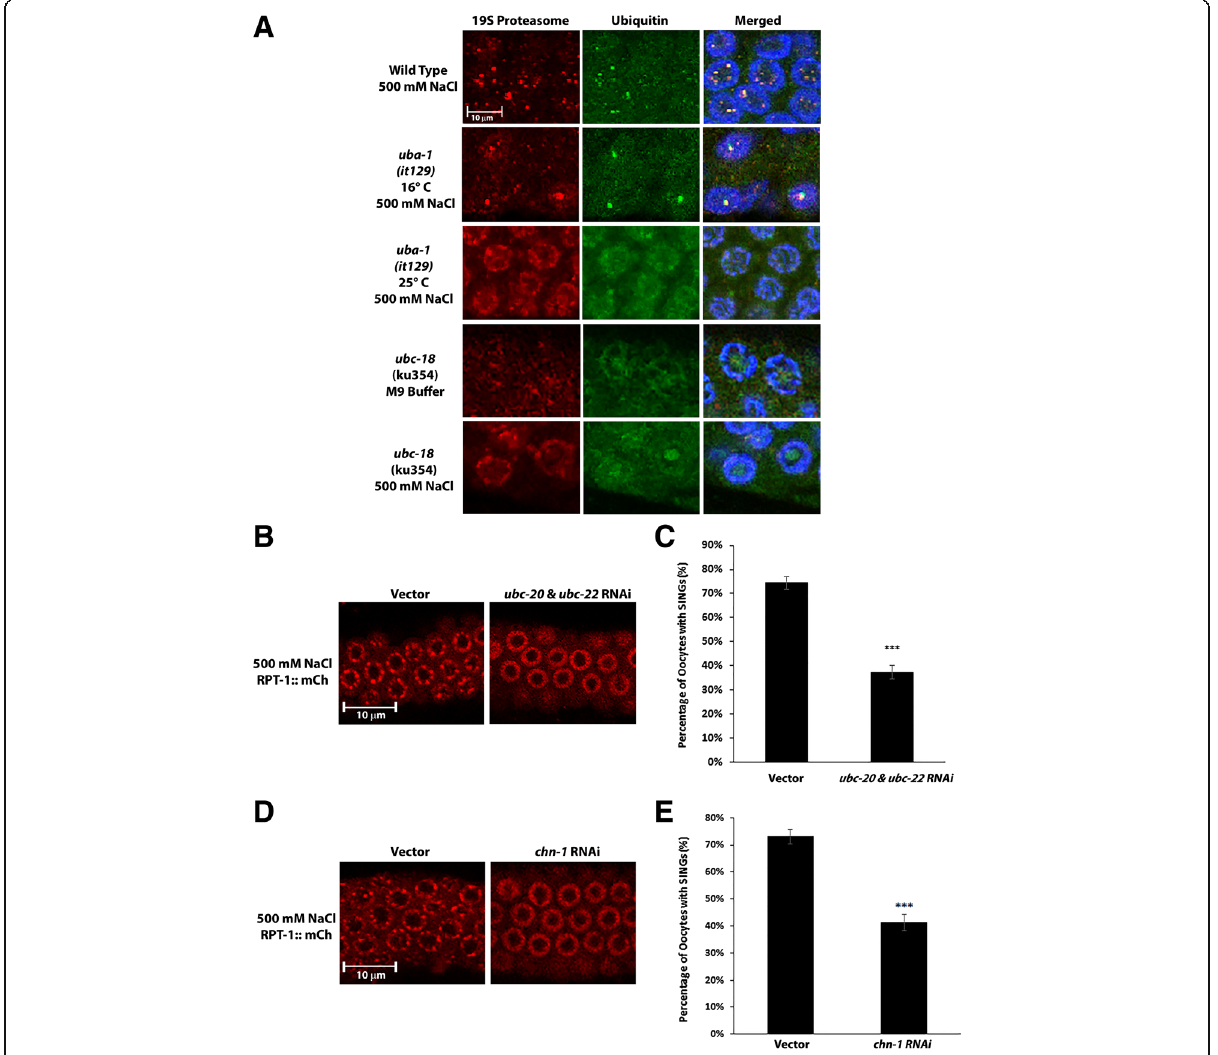
Fig. 5 Ubiquitination pathway components participating in SING formation. a SINGs in uba-1 and ubc-18 mutants. Antibodies to ubiquitin and the 19S proteasome were used to stain wild type worms, a temperature sensitive mutant of uba-1, and a loss of function mutation in ubc-18. The merged images show the ubiquitin, proteasome, and DAPI channels. uba-1 worms grown at 16 °C showed the presence of SINGs (551/600 oocytes) in response to salt stress (500 mM NaCl for 60 min). However, uba-1 worms grown at 25 °C showed a reduction in SING formation (12/600 oocytes) when exposed to salt stress. SINGs were not induced in ubc-18 mutants during salt stress (0/600 oocytes). Data were collected from 3 independent experiments ( n = 30 worms). Scale bar indicates 10 μ m. b Worms expressing RPT-1::mCh were subjected to either control RNAi (vector) or RNAi of the ubc-20 plus ubc-22 E2 enzymes. This combined RNAi reduced the appearance of SINGs. Scale bar indicates 10 μ m. c Quantification of the percentage of oocytes forming SINGs after control RNAi and chn- 1 RNAi treatment as described in B. A total of 1020 oocytes were observed from 3 independent experiments ( n =30 worms). Statistical significance was calculated by a two-tailed z test: *** p <0.001. d Worms expressing RPT-1::mCh were subjected to either control RNAi (vector) or RNAi of the chn-1 E3 enzyme. Knockdown of chn-1 reduced the appearance of SINGs. Scale bar indicates 10 μ m. e Quantification of the percentage of oocytes forming SINGs after treatment as described in D. A total of 1020 oocytes were observed from 3 independent experiments ( n =30 worms). Statistical significance was calculated by a two-tailed z test: *** p